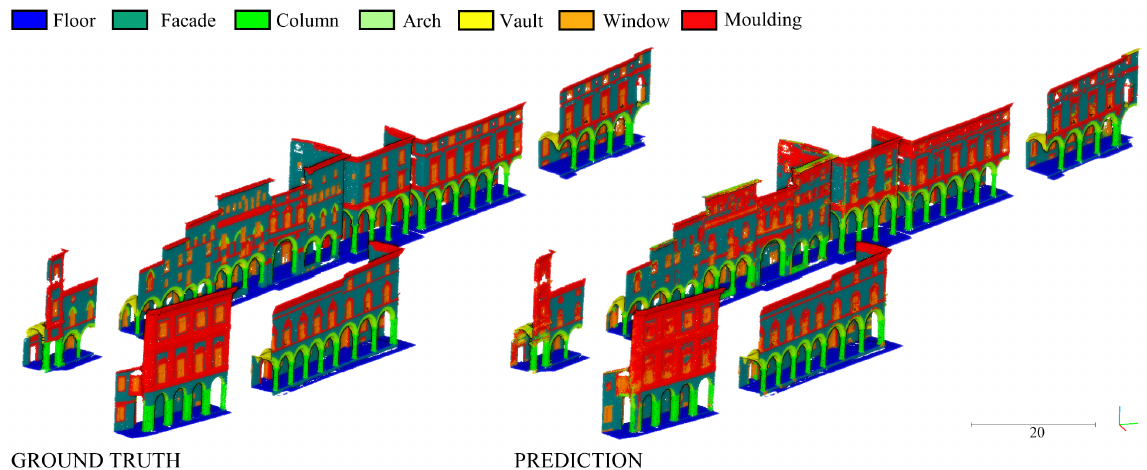
Figure 10. Visual comparison between the hand-annotated Bologna dataset (left) and the prediction achieved with the proposed method